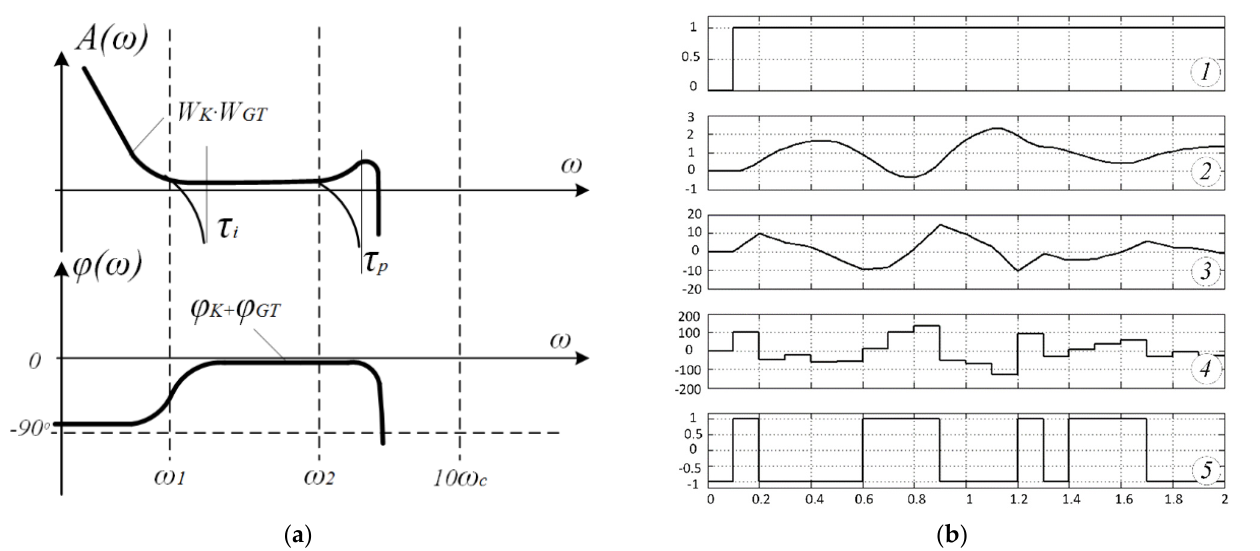
Figure 13. Logarithmic amplitude–frequency characteristics of VSS ( a ) and transient processes in the model with an increased time delay in the differentiation link at which the system is unstable ( b ). 1 Reference signal. 2 Adjustable value. 3 Derivative. 4 Derivative signal after a discrete link. 5 Relay element output.